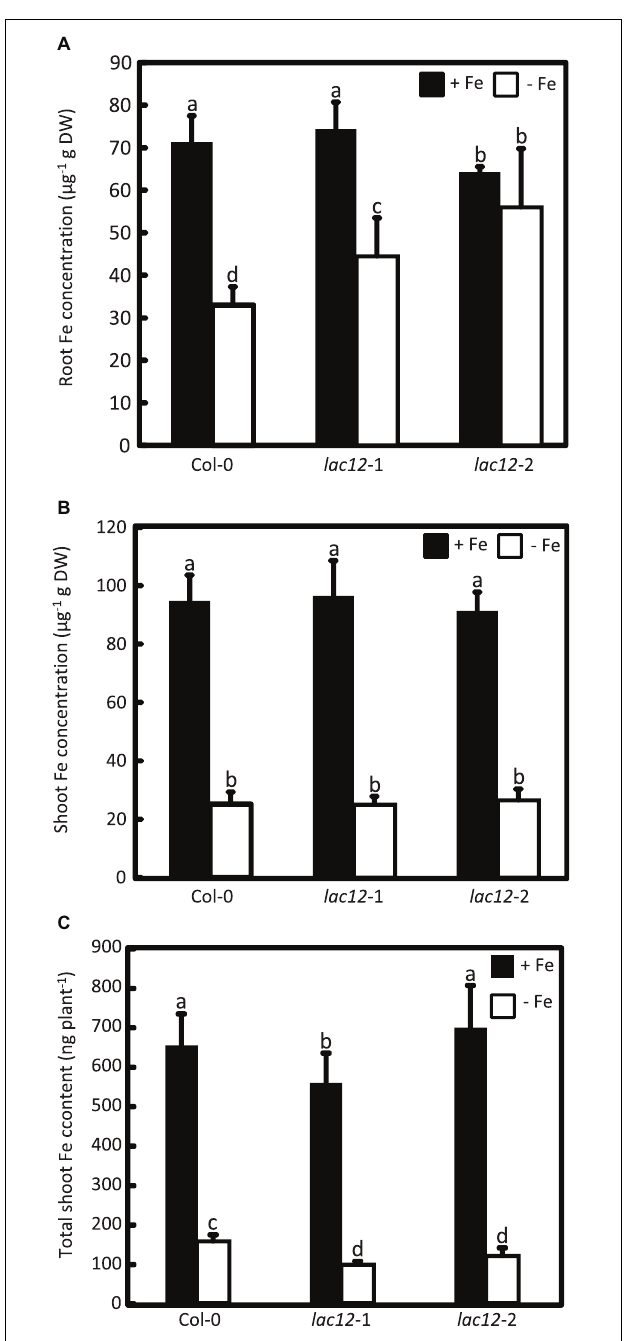
FIGURE 4 | Arabidopsis lac12 mutants accumulate higher Fe concentrations in roots and contain lower total shoot Fe than the wild-type when cultivated under Fe deficiency. Fe concentrations in (A) roots and (B) shoots, and (C) total Fe content in shoots, of WT, lac12 -1 and lac12 -2 seedlings grown on vertically oriented petri plates as described in Figure 3 . Values are arithmetic means ± SD of three biological replicate plates from one experiment representative of three independent biological experiments. Metals were quantified in pooled tissues from 15 seedlings per replicate plate. Different characters denote statistically significant differences ( P < 0.05) between genotypes and Fe treatments based on ANOVA (Tukey’s HSD).